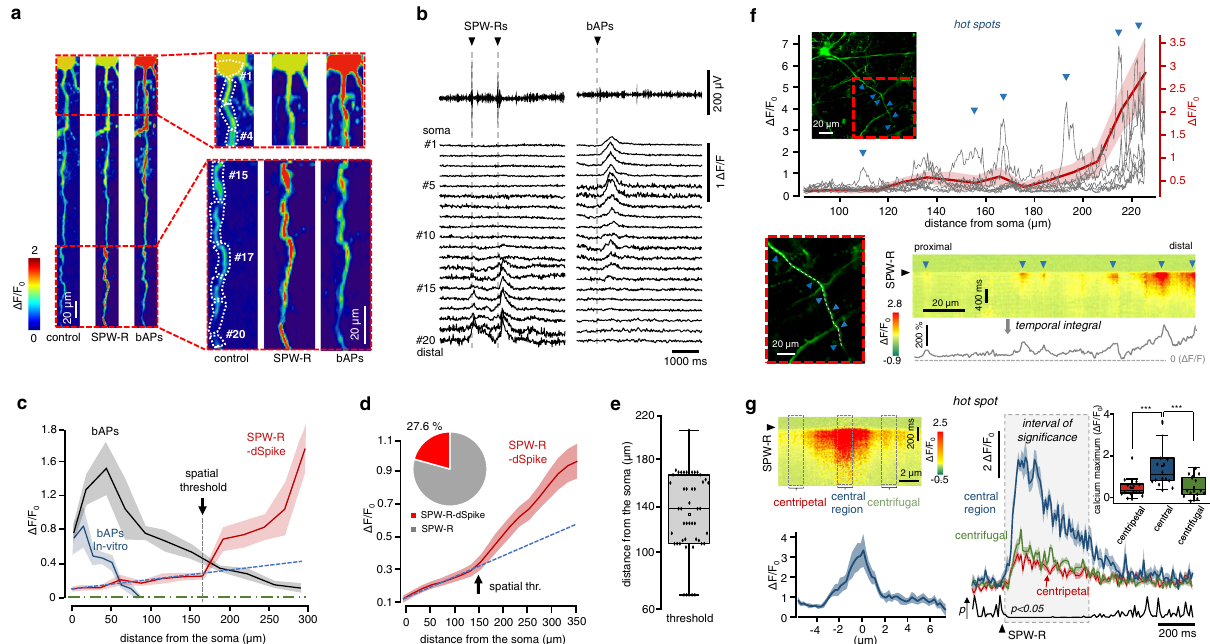
Fig. 2 | Spatial characterization of SPW-R-dSpikes in CA1 PV+ interneurons of awake mice. a Example dendritic 3D Ca 2+ responses from dendrite #1 shown in Fig. 1h at rest (control), during an SPW-R event (SPW-R), and during SPW-R inde- pendentputativebackpropagatingAPs(bAPs). b IndividualCa 2+ responsesspatially averaged for the numbered dendritic regions indicated in a show a distance- dependent decrease and increase during putative bAPs and SPW-Rs, respectively. c Spatial distribution of the average dendritic 3D Ca 2+ responses from dendrite #1 during putative bAPs and SPW-R-dSpikes (mean±SEM, n =4/5 bAPs/spikes). Black arrowindicatesthespatialthresholdsofthespike.Bluedashedlineindicateslinear fi t to the proximal dendritic regions. Blue transients are overlaid with averaged 3D Ca 2+ responses recorded in vitro and were induced by 5 APs. d Average SPW-R- dSpike-associated dendritic 3D Ca 2+ responses as a function of distance from the soma ( n =11/5 cells/mice). Blue dashed line and black arrow indicate same as on panel c . Inset, pie chart denotes reliability of reactivation of the dendritic spike during successiveSPW-Rs(75spikes/ 287SPW-R events/11 dendrites).The average lengthofthe recorded dendrites was314.2±43.1 µ m (mean±SD). e Distribution of